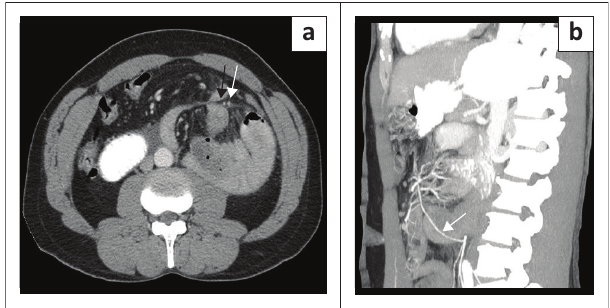
Source : Image utilised from the PACS of Jackpersad and Partners Inc. FIGURE 3: (a) Axial portal venous phase and (b) sagittal reformatted maximum intensity projection images demonstrating the left paraduodenal hernia in relation to the vascular landmarks. Ascending branch of the left colic artery (white arrow) noted on the axial portal venous phase and sagittal reformatted maximum intensity projection image, as well as the inferior mesenteric vein (black arrow) on the axial portal venous phase, approximating the anterior margin of the left paraduodenal hernia.